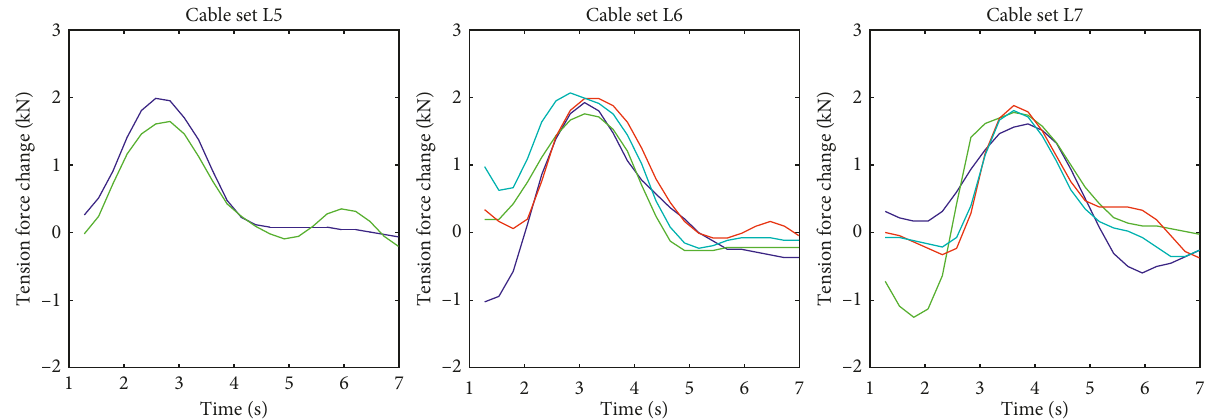
Figure 15: Time history of variation of tensile forces of individual cables in each set. Table 4: Peak force (kN) change results.